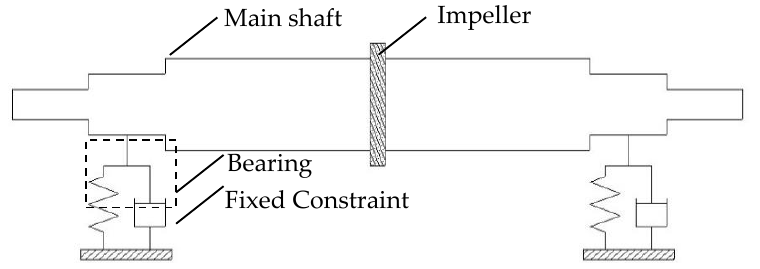
Figure 2. Schematic diagram of the rotordynamics model.